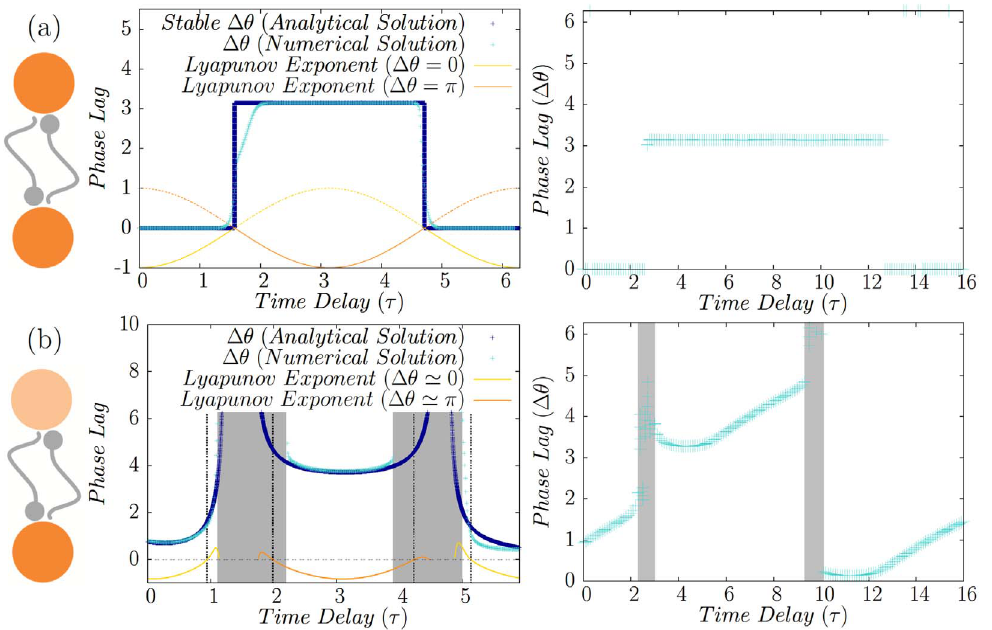
Fig. 2. Homogeneous and inhomogeneous system of directly coupled neurons. (a) Synchronized states of two directly coupled identical type-II neurons. Depending on the delay time inphase or antiphase modes are stable with negative corresponding Lyapunov exponent which are shown for both the ) of firing of two identical Hodgkin-Huxely neurons is plotted in the right panel. (b) Synchronized states of two states (left panel). Phase difference ( 2 p t n 1 { t n 2 T directly coupled neurons in presence of frequency mismatch. Numerical solutions (Cyan) affirm the validity of the analytical results obtained from linear approximation (Dark Blue). Lyapunov exponent for each of the locked states are also shown. Shaded area show the regions where no 1:1 locking mode is seen in numerical results, and the dashed gray lines are the boundary of stability of analytic solution with negative Lyapunov exponents. In the right panel the phase difference is shown for two HH neurons with different firing rates.